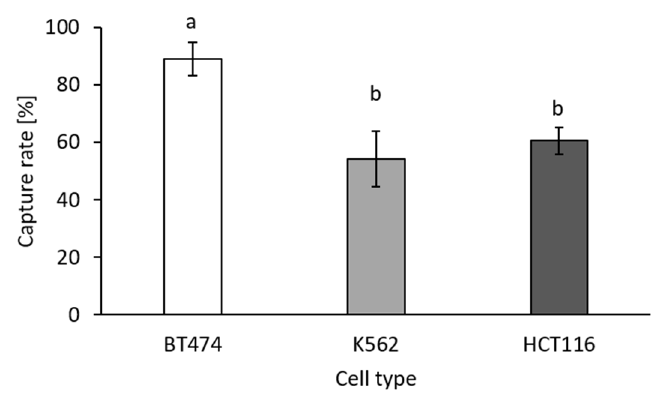
Figure 8. Capture rates for cell lines BT-474 ( n = 5), K562 ( n = 4), and HCT116 ( n = 10) spiked into whole blood samples and filtration at a constant flow rate of − 2 µL/s as determined by end-point detection. Results are given as means ± SD. Different letters (a and b) above the bars indicate statistical significance, results with the same letters (b and b) are not significantly different ( p < 0.05).